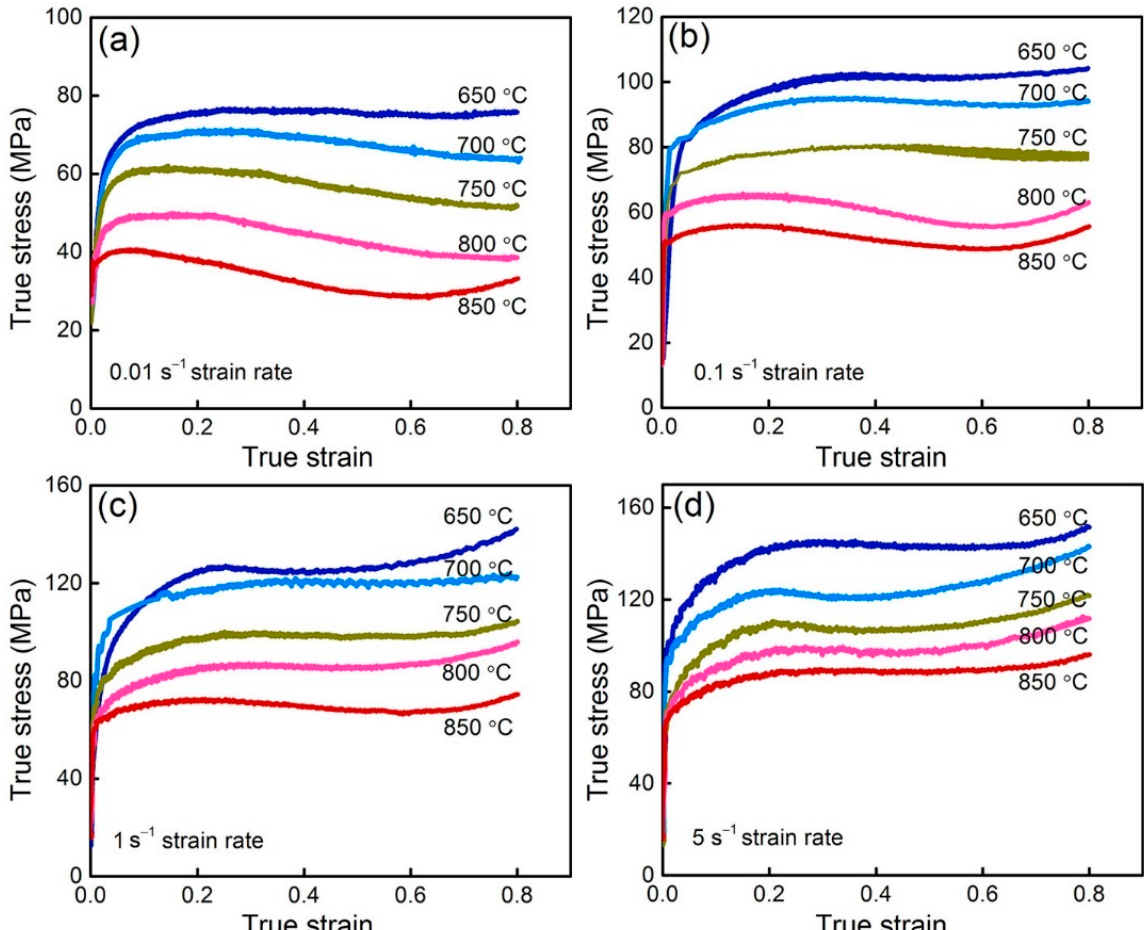
Figure 3. Relationship between the true stress and strain of the ZnSnO 3 /Cu composites at 650–850 °C and strain rates: ( a ) 0.01 s − 1 , ( b ) 0.1 s − 1 , ( c ) 1 s − 1 , and ( d ) 5 s − 1 .